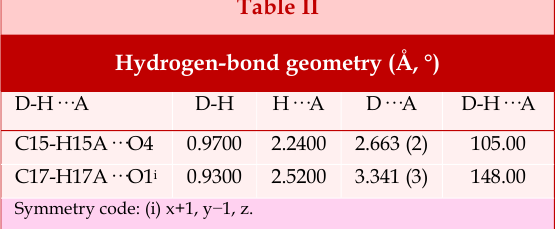
Hydrogen-bond geometry (Å,